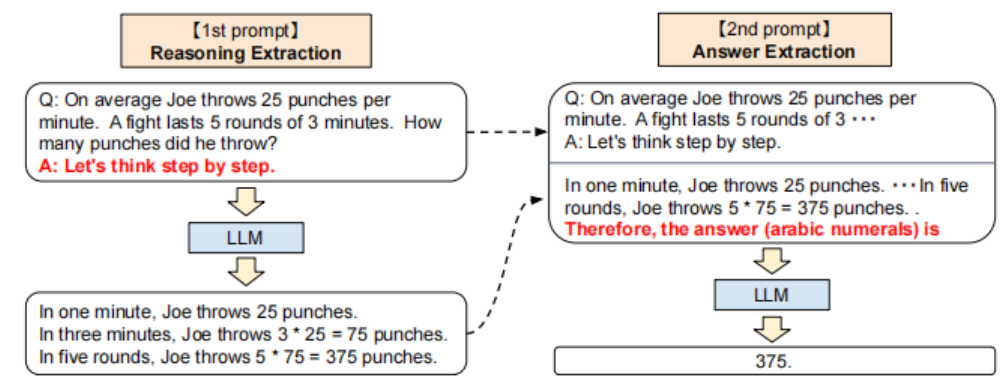
Figure 6 Two-stage prompt process demonstration. GPT-3 can produce better solutions to mathematical problems when prompted with “Let's think step by step”, showing the ability of chain-of-thought. This method can help the model generate more accurate results when facing complex problems and limited sample sizes situations [20].